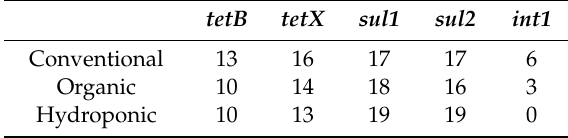
Table 2. Frequency of lettuce samples carrying resistant genes 1 .